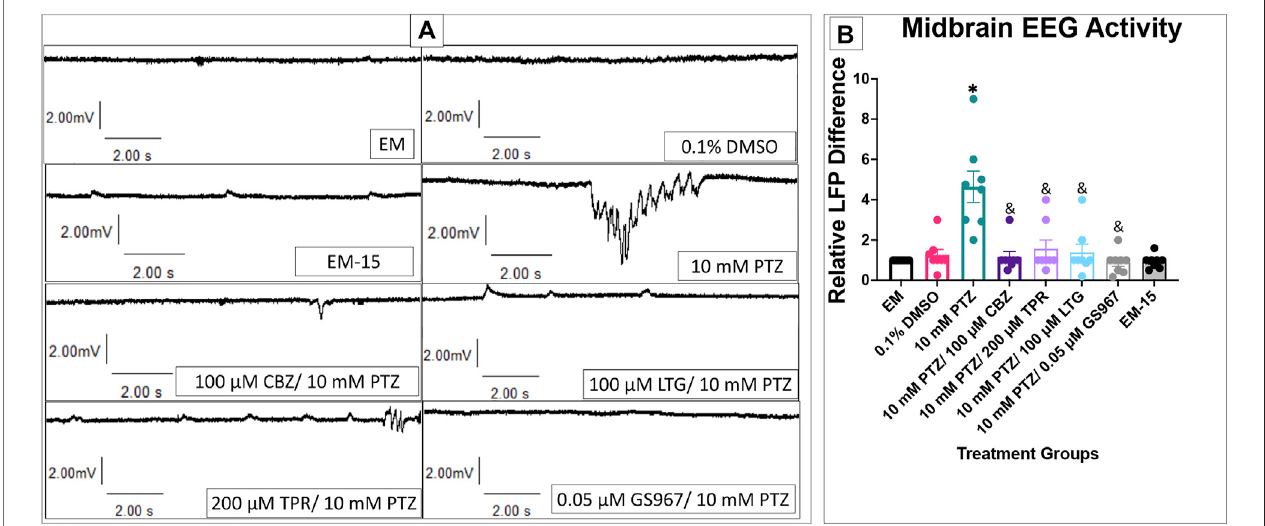
FIGURE 7 | Local fi eld potentials in 7 dpf larvae. (A) Representative tracings recorded in the presence of EM (top) and 10 mM PTZ (bottom) are shown. (B) The relativeLFP differenceis displayed on the y -axis. The respective treatment groups are shown on the x -axis. Analyses(one-way ANOVA, Tukey ’ s post-hoc) are marked * ( p < 0.05)toindicatesigni fi cantdifferencestoembryomedium(EM).Standarderrorofthemeansisshown.Analyses(one-wayANOVA,Tukey ’ spost-hoc)aremarked& ( p < 0.05) to indicate signi fi cant differences to 10 mM PTZ. ( n = 8 fi sh/treatment